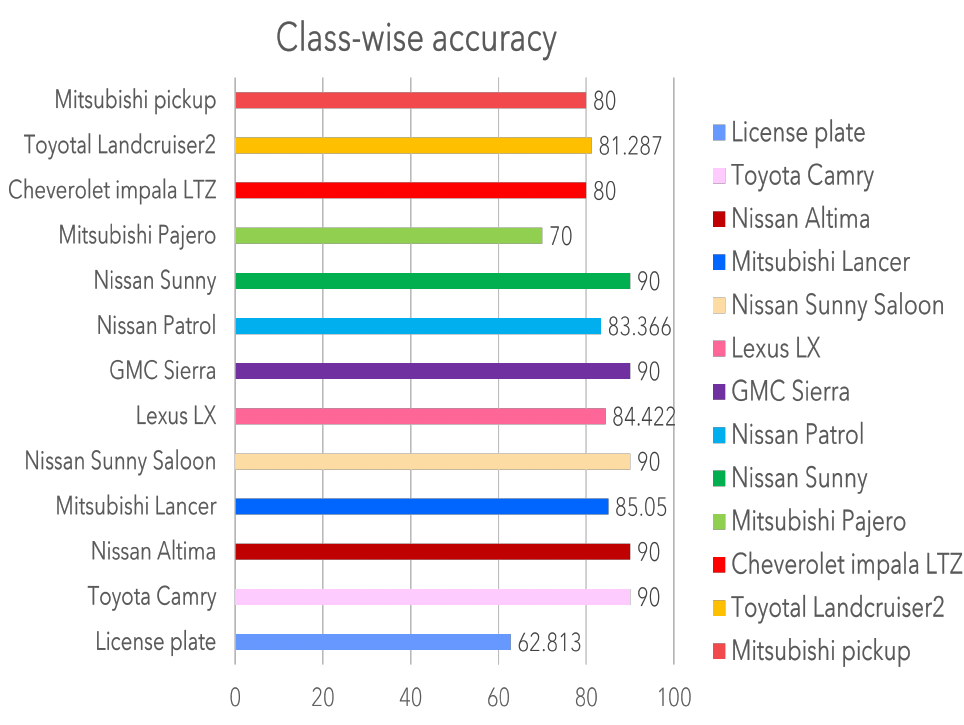
Figure 8. Class-wise accuracy based on the maskRCNN–Resnet-50